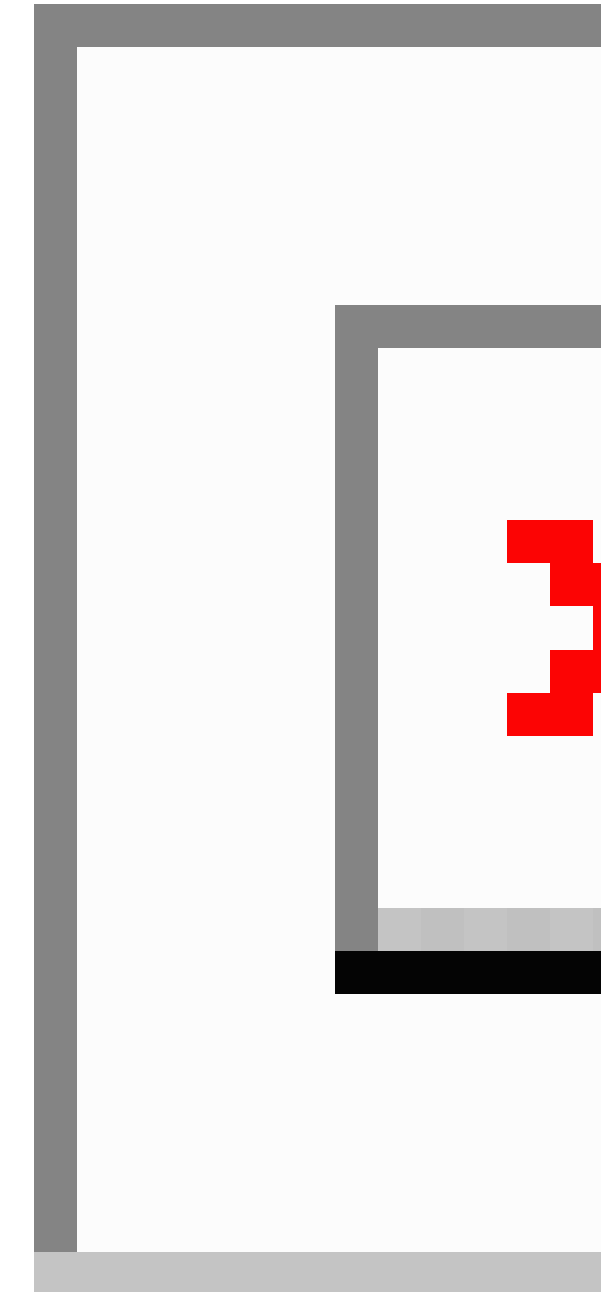
Figure 2. Symbols used by 7 of the 10